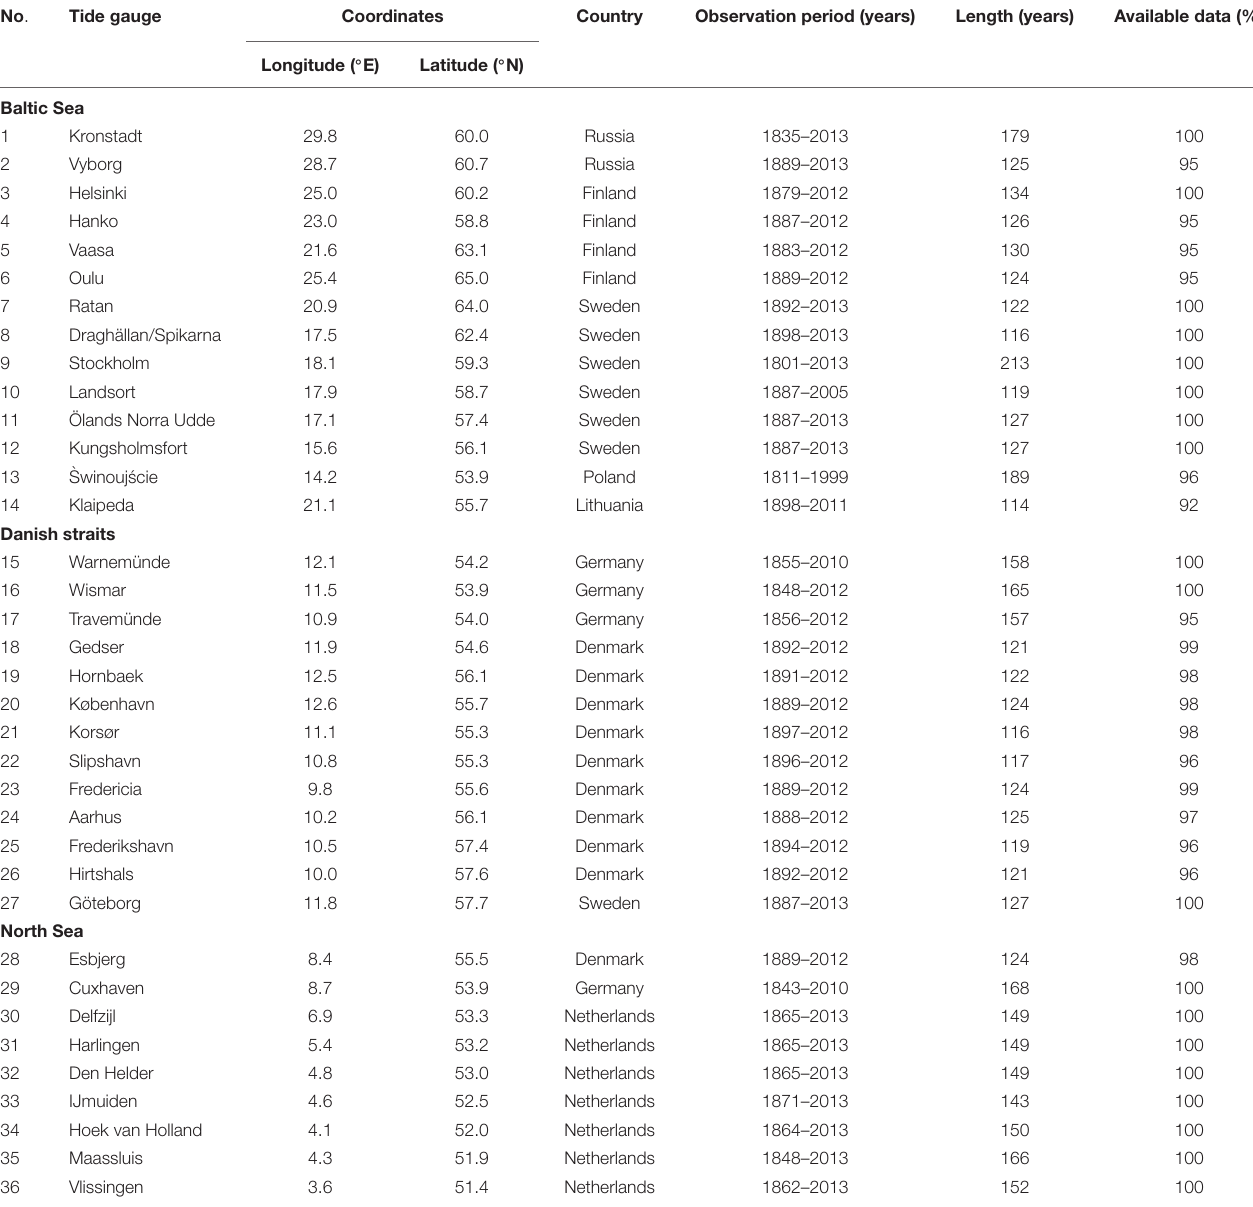
TABLE 1 | The monthly MSL records in the Baltic Sea and the Southeast North Sea. No